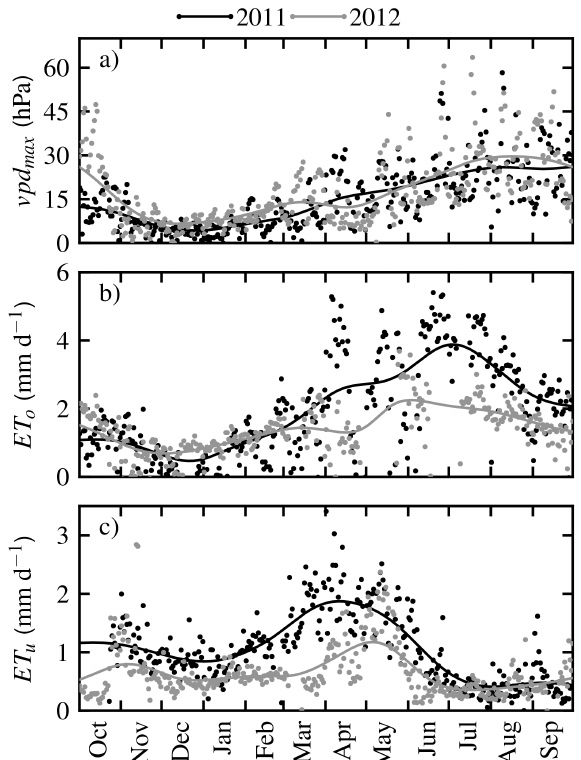
Figure 4. (a) Maximum daily vapour pressure deficit vpd max , (b) daily sum of ecosystem evapotranspiration ET o and (c) daily sum of understorey transpiration and soil evaporation ET u for 2011 (black) and 2012 (grey). Lines mark kernel